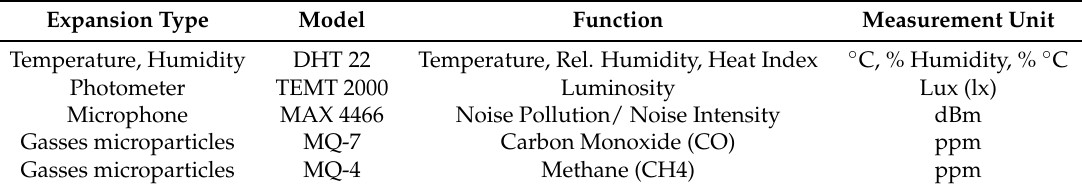
Table 1. Expansions, Functions and Units used on the recording